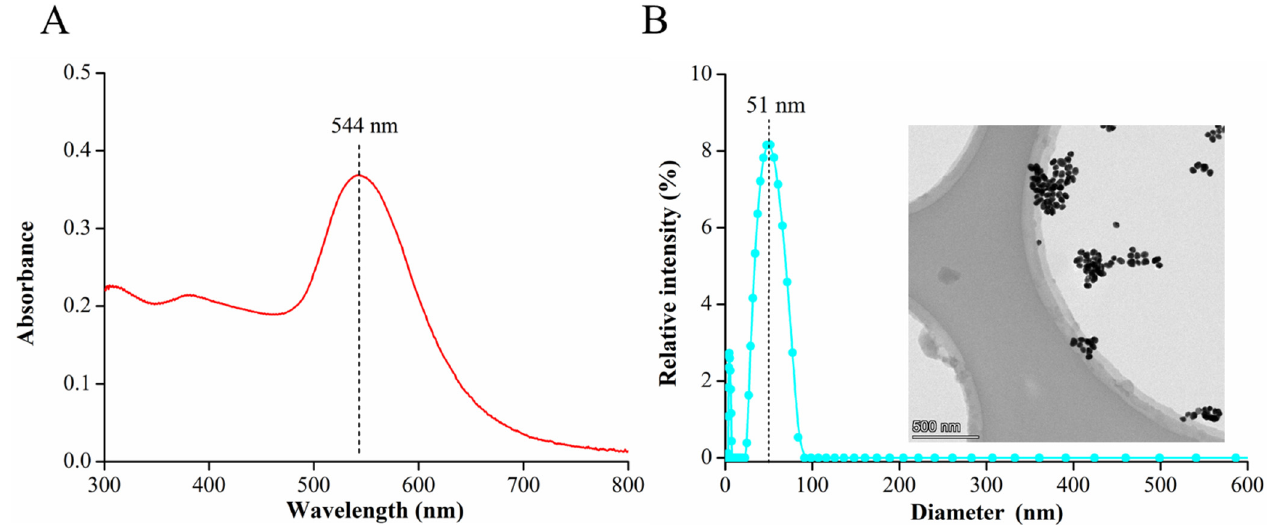
Figure 1. ( A ) UV-Vis absorption spectrum of the synthesized Au NP colloid. ( B ) Size distribution (main panel) and transmission electron microscope image of the synthesized Au NPs (insert panel).